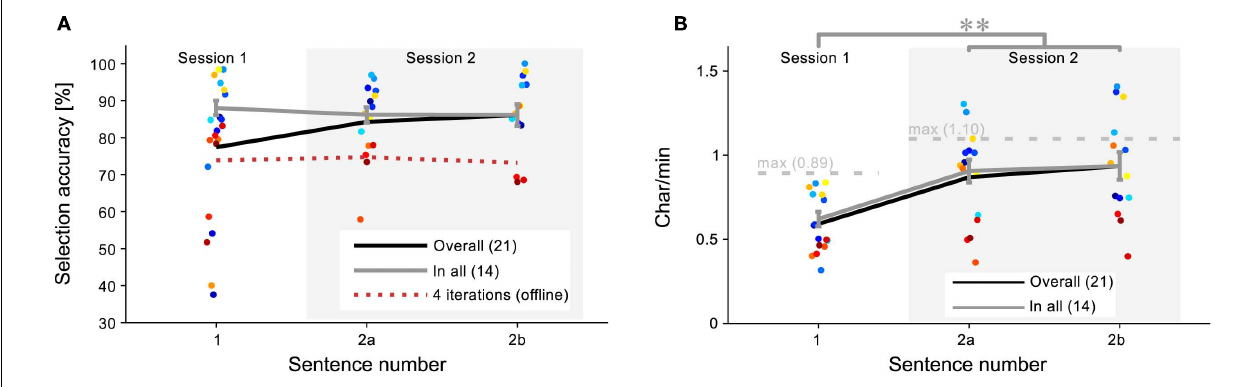
represented by the red, dotted line. (B) The char/min for Session 2 was significantly better than for Session 1, which is due to early stopping and less label vocalization. Some subjects performed higher than the theoretic maximum char/min, indicating a particular benefit from the dynamic stopping mechanism. Points are slightly displaced on the horizontal axis to prevent